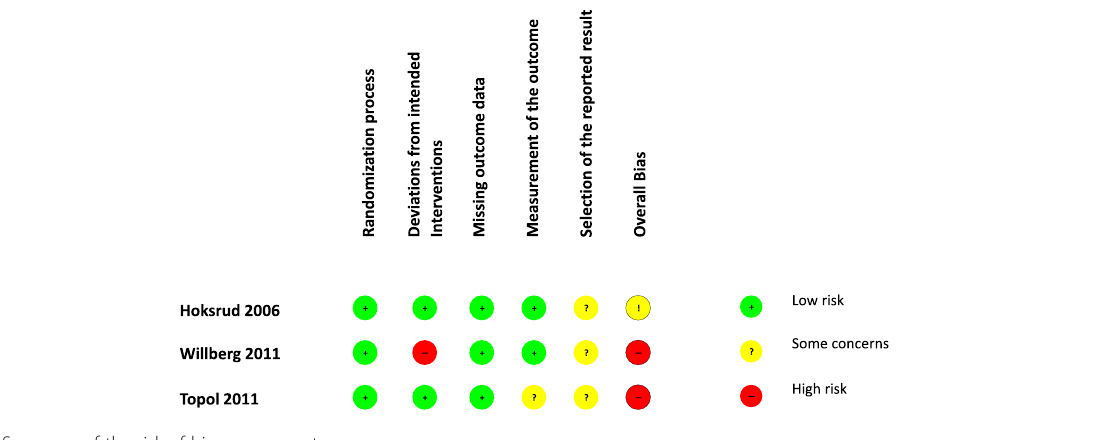
Fig. 2 Summary of the risk of bias